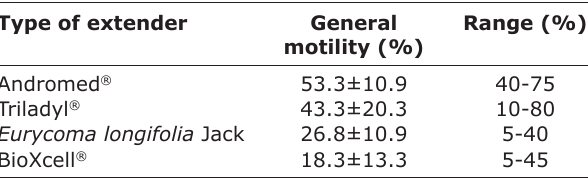
Table-4: General motility mean±SEM (%) of Rusa timorensis postcryopreservation with different extenders. Type of